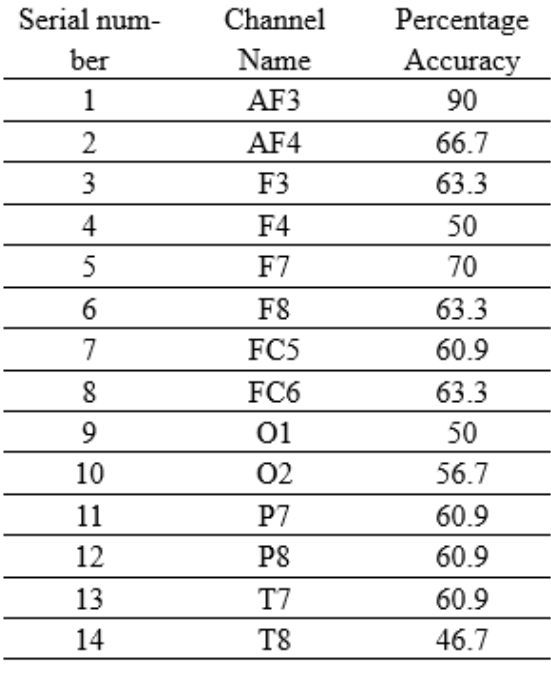
Table 2. Confusion Matrix result for classifica - tion of NWL, LWL and HWL, after applying NN clas - sifiers with 1000 iteration for